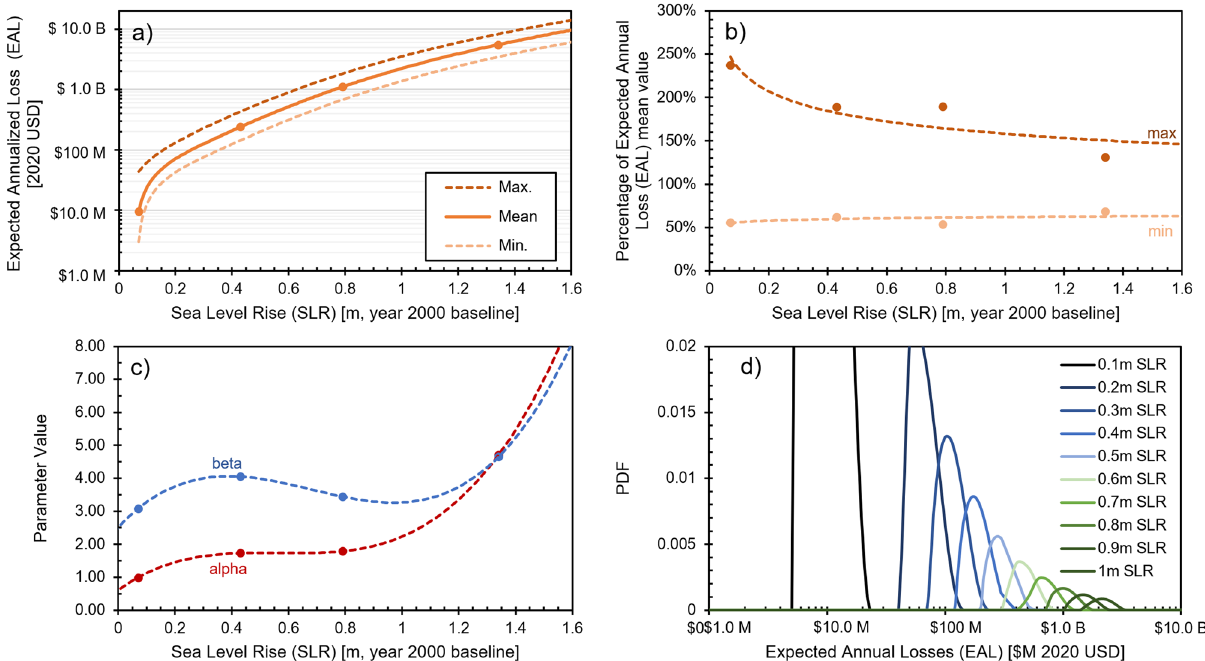
Fig. 4 MBTA rail rapid transit system Expected Annual Loss (EAL) characteristics. a Min (light orange dashed line), mean (orange solid line and data points), and max (dark orange dashed line) EAL vs. sea level rise (SLR). b Min (light orange) and max (dark orange) EAL as a percentage of EAL mean value. c generalized beta distribution parameter values (alpha parameter in red, beta parameter in blue) vs. SLR. d EAL probability density functions for several sample SLR values (color gradient from navy blue to forest green for increasing SLR values).